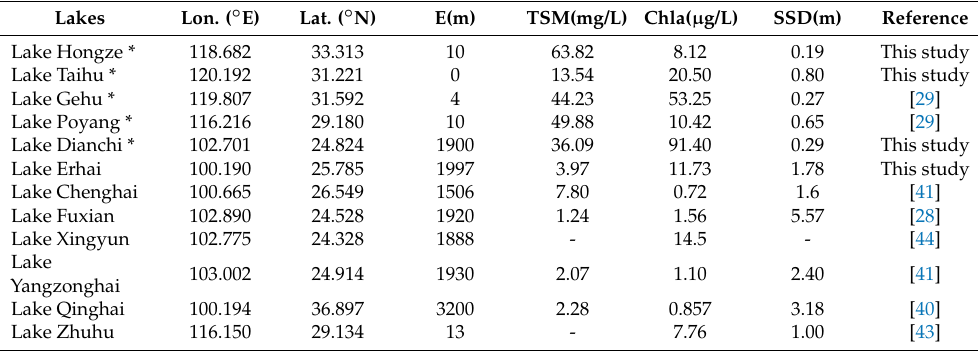
Table 1. Water quality parameter mean values refer to previous studies and measured data (the turbid lakes are marked by the symbol *, respectively; E: elevation of water surface; TSM: Total Suspended Matter; Chla: Chlorophyll a; SSD: Secchi Disk Depth).